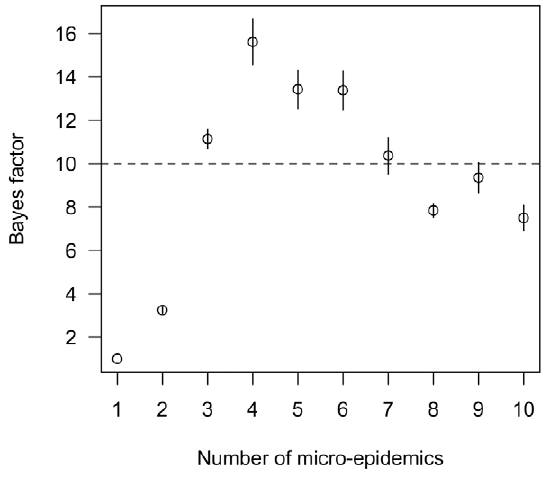
Figure 1. Comparison of the fit of multi-epidemic models for describing T.cruzi transmission in Guadalupe, Arequipa, Peru to a single epidemic model. Shown are the mean and standard error of the estimated Bayes’ factors for comparing each model to the 1 epicenter model. The dotted line denotes models with strong support relative to the 1 epicenter model (Bayes’ factor . 10).